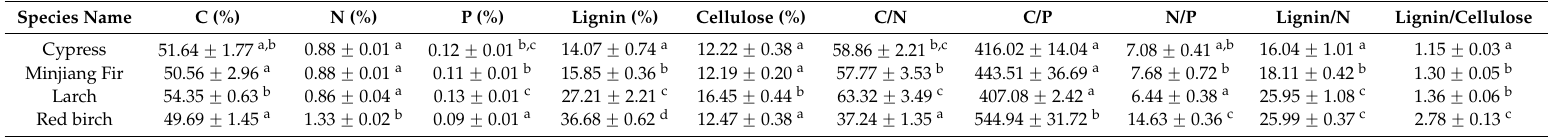
Table 2. Initial quality of the four types of foliar litter (cypress, Minjiang fir, larch, red birch) in an alpine Minjiang fir forest (mean ˘ SD, n = 3).